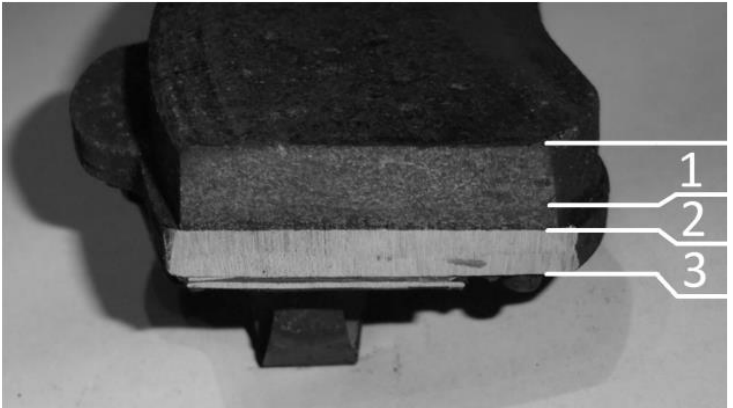
Figure 1. Cross-section of the real-life object of study: 1 — friction material; 2 — adhesive layer (interlayer); 3 — back plate.